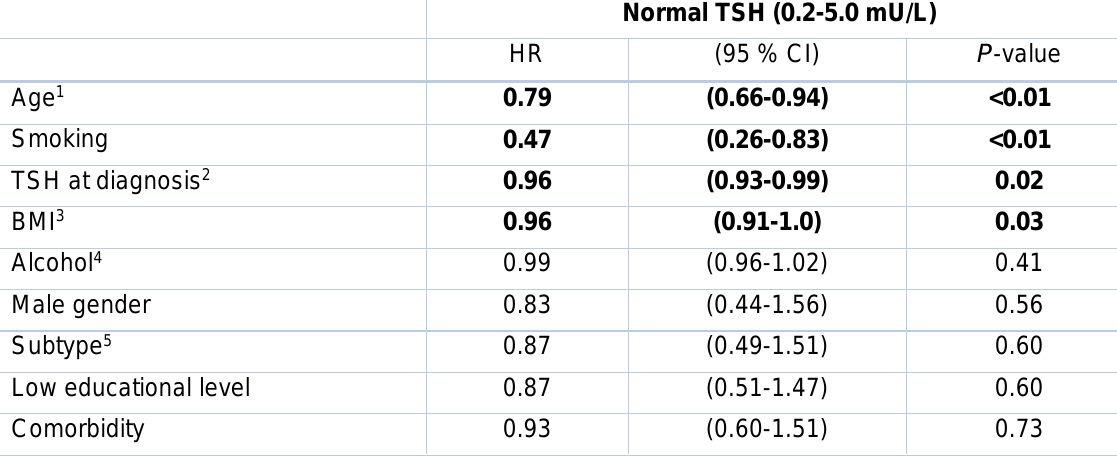
Table 3: Multivariate analysis with cox proportional hazards regression, showing hazard ratios (HRs) with 95 % confidence intervals (CI) for first TSH within normal range according to clinical and